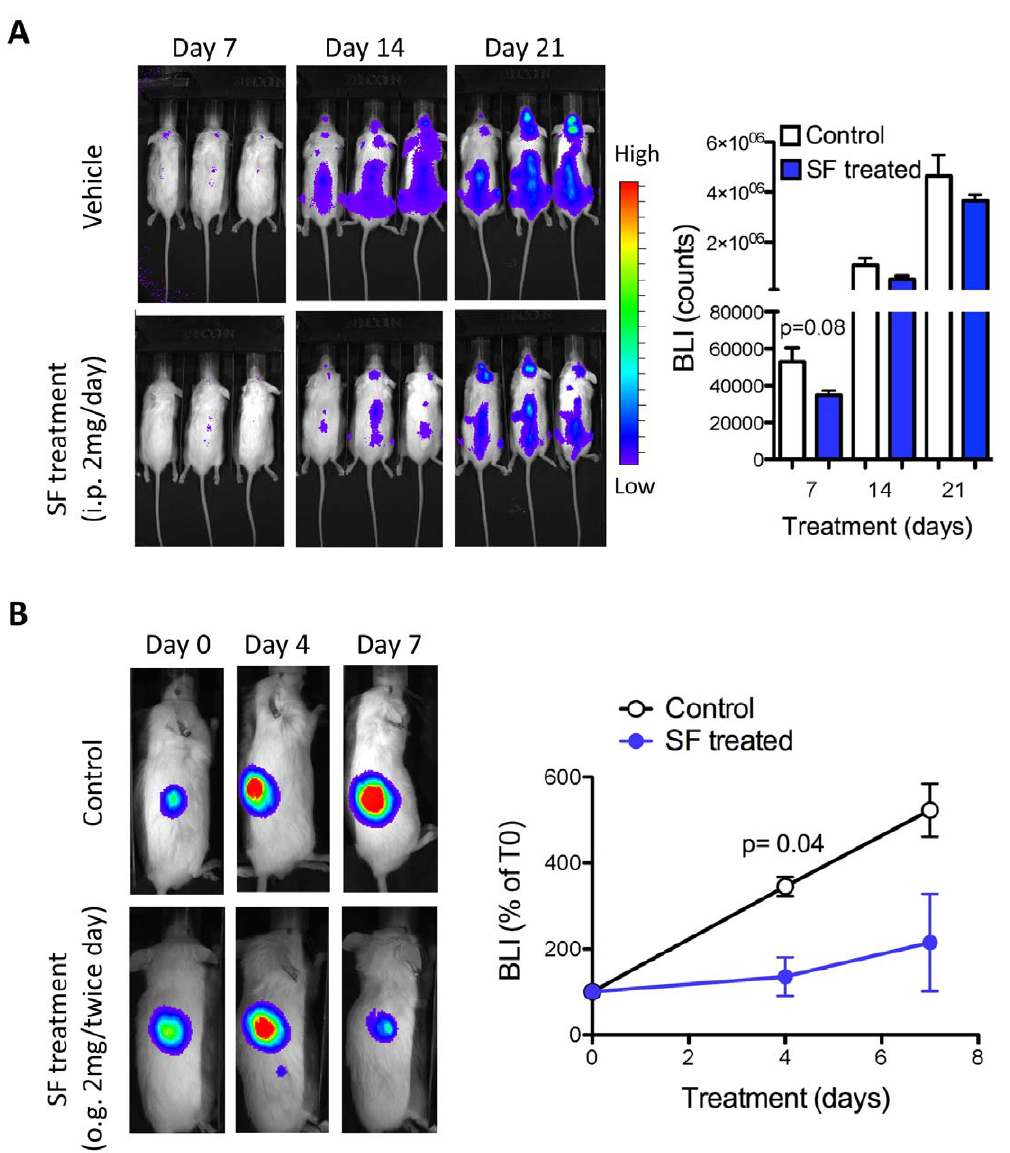
Figure 6. Invivo anti-leukemic effect of SF in ALL xenograft models. (A) Nalm-6 cells were transduced with the FFluc retrovirus and injected intravenously into NOD/SCID mice. Twenty-four hours later, the mice were treated with SF or vehicle (2 mg i.p. daily) and monitored weekly for the distribution of leukemic cells by bioluminescence imaging (BLI). (B) The Nalm-6-FFluc cells were mixed with a high-protein matrigel and injected into the flank of NOD/SCID mice. One week later, tumor establishment was confirmed by BLI; then, the mice were treated by oral gavage (2 mg/gave, twice daily) for 7 days. The total counts were determined for the control- and SF-treated mice. The data are representative of three independent experiments. The statistical significance was calculated using the two-tailed Student’s t